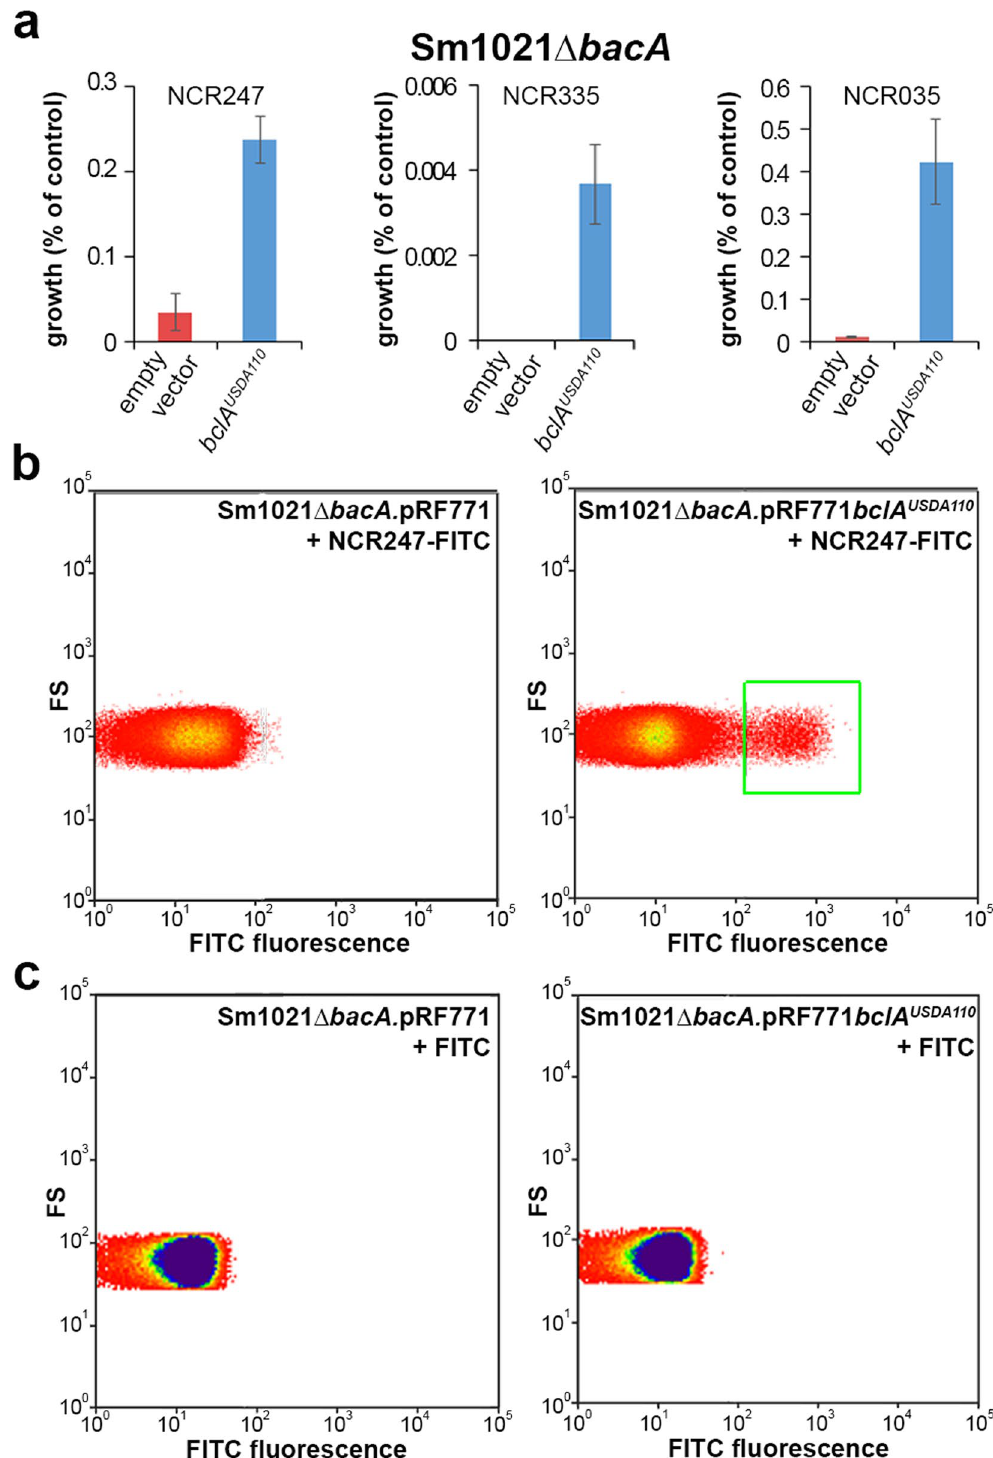
Figure 2. The USDA110 bclA gene confers resistance to antimicrobial NCR peptides and mediates the uptake of FITC-NCR247. ( a ) S. meliloti strain Sm1021 Δ bacA derivatives expressing no bacA -related gene (empty vector) or the USDA110 bclA gene were incubated with NCR247, NCR335 or NCR035 or with water (control) and the surviving bacteria were counted and expressed as % from the control treatment. Error bars in all panels are standard deviations. ( b ) FITC-NCR247 uptake by S. meliloti strain Sm1021 Δ bacA or its derivative expressing the USDA110 bclA gene was measured by flow cytometry in the presence of trypan blue to quench extracellular fluorescence. FITC-positive cells are marked with a green box. ( c ) FITC is not taken up by S. meliloti derivatives. FITC-treated bacteria were analyzed by flow cytometry in the presence of trypan blue to quench extracellular fluorescence. No FITC-positive cells were